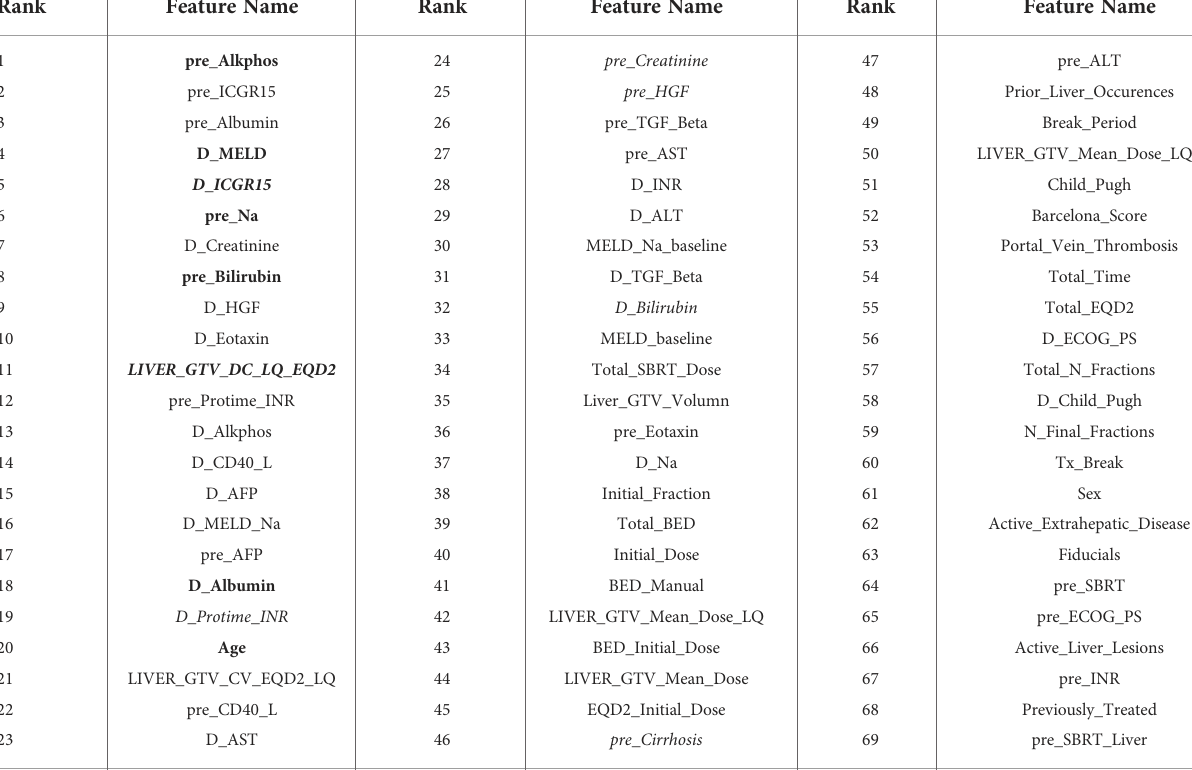
TABLE 4 The rank of features in an integrated feature ranking list for during-treatment I-ALBI prediction.